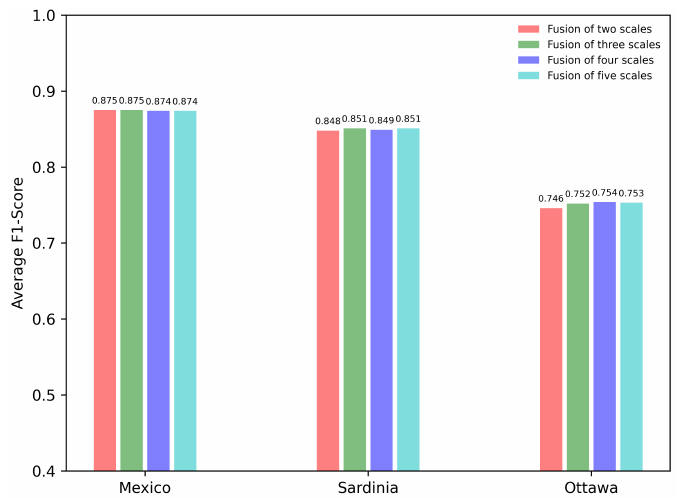
Figure 8. Average F1 scores of fusing various number of scales for the three experimental